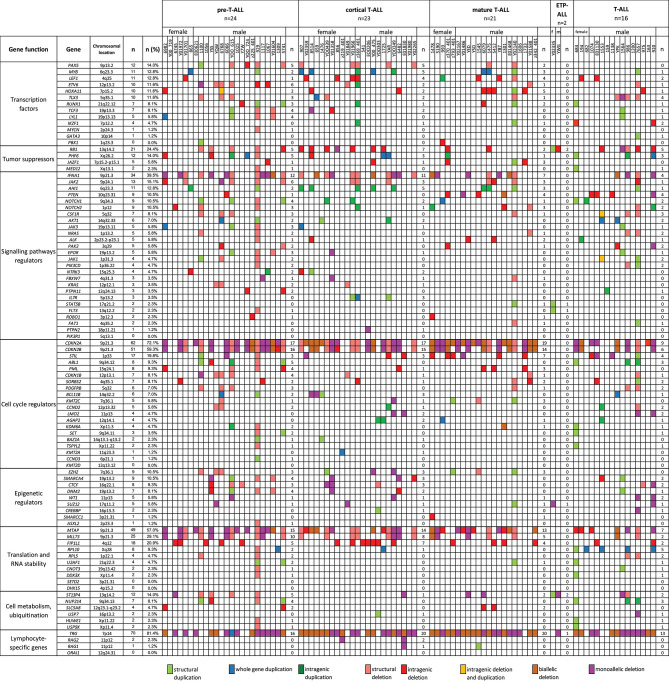
The frequencies of CNAs of all 92 selected genes in 86 T-ALL cases according to particular T-ALL subtypes. Owing to the small amount of data on the CNA frequency observed in T-ALL (data reported thus far are focused on the mutation status of analyzed genes), it is unclear what effects individual changes have on the pathogenesis and course of T-ALL.